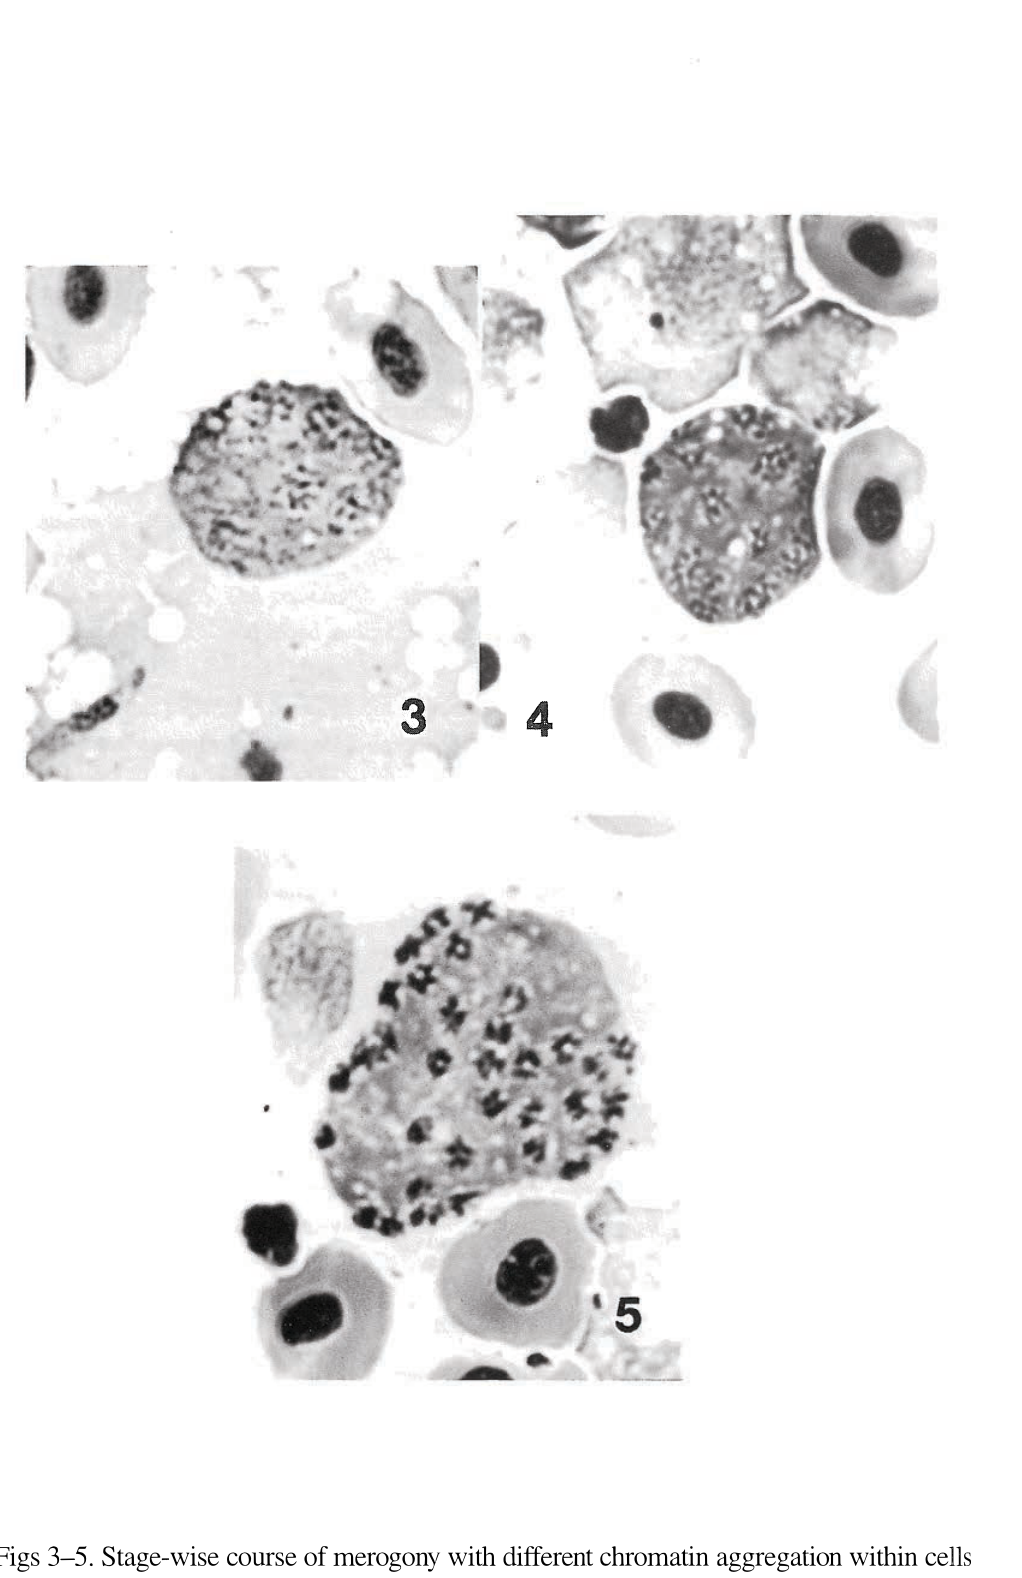
Figs 3-5. Stage-wise course of merogony with different chromatin aggregation within